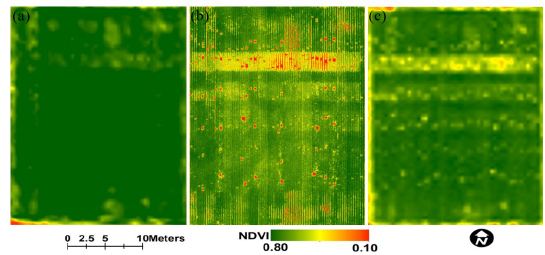
Figure 3. Spatiotemporal change of NDVI. Spatial distribution of NDVI calculated from WV3 satellite